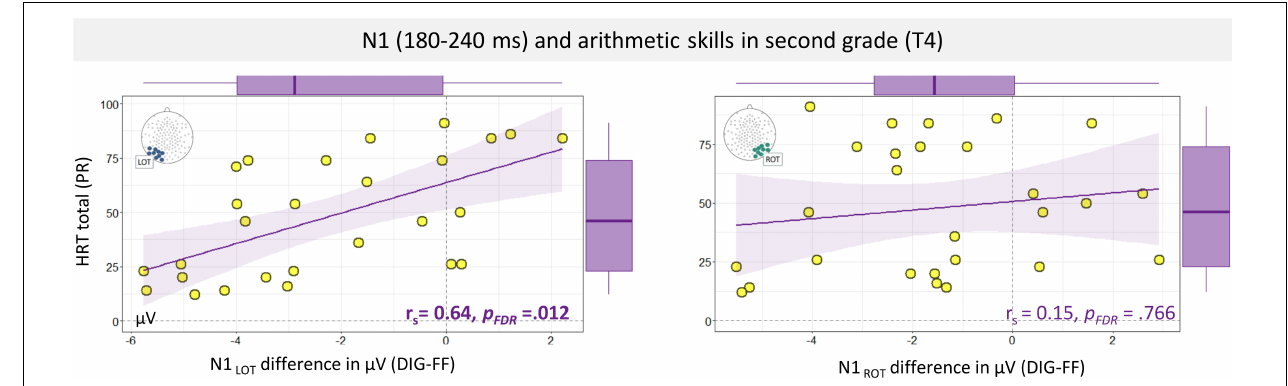
FIGURE 6 | Spearman correlation and regression line of trends between total percentile score of arithmetic operations (HRT total) and N1 digits-false font amplitude differences in the left and right ventral-occipital electrodes. Box plots are displayed in the margins. LOT, left occipito-temporal; ROT, right occipito-temporal; DIG, digits; FF, false fonts; HRT, Heidelberger Rechentest; PR, percentile.